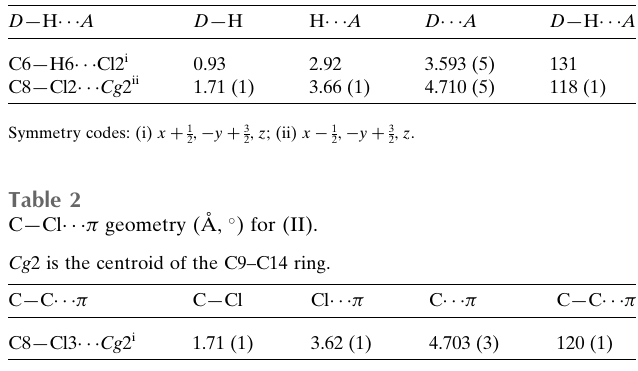
Table 1 Hydrogen-bond geometry (A˚ , (cid:2) ) for (I). Cg 2 is the centroid of the C9–C14 ring.